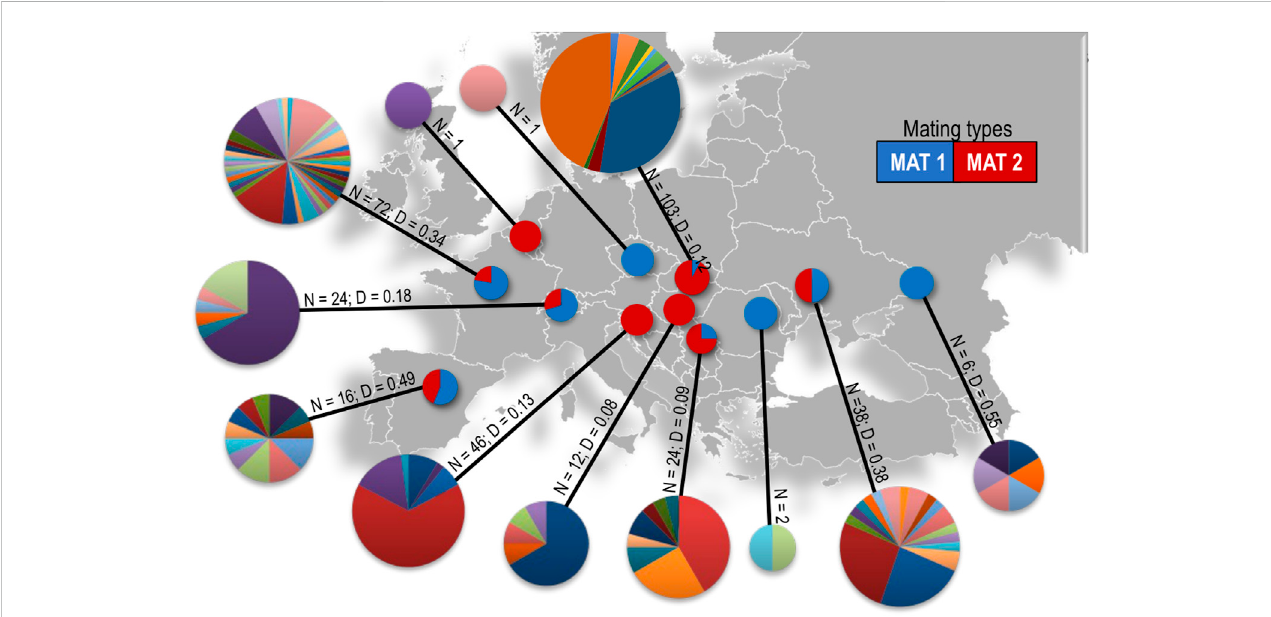
FIGURE 2 Microsatellite haplotype diversity and mating type ratios of D. pini in each of the sampled countries in Europe. Each colour in the pie charts represents a differentmultilocushaplotype.ThesizeofeachMLHpiechartisproportionaltothenumberofisolatespercountrywhereBelgium N =1andSlovakia N =103. N = number of isolates, D = Nei ’ s genetic